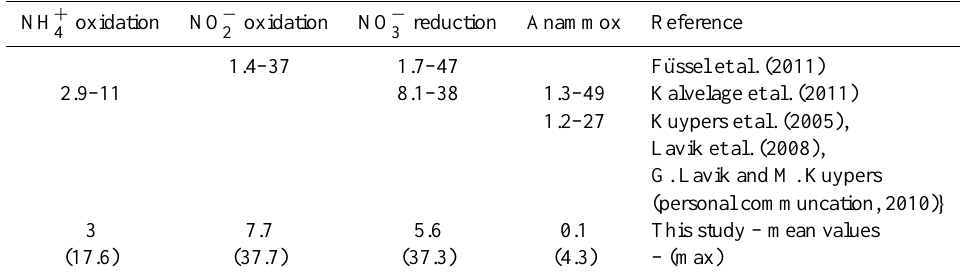
Fig. 12. Vertical profiles of horizontally averaged (a) and maximum (b) N 2 O concentrations between 22–24 ◦ S and 10–15 ◦ E (in 10 − 3 mmolN 2 Om − 3 ) from the surface to 600m depth for different parameterizations (Nevison et al., 2003; Suntharalingam et al., 2000, 2012), β coefficient (Suntharalingam et al., 2000, 2012), and sensitivity analyses on key parameters. Vertical profiles were 8yr averaged. Vertical profiles of averaged N 2 O concentrations between 22–24 ◦ S and 12.5–15 ◦ E, zonal extension of the OMZ at this latitude range, overlap in (a) . Red stars represent in situ measurements from the FRS Africana cruise in December 2009. Table 6. In situ and simulated estimations of NH + and NO − oxidation, NO − reduction, and anammox (10 − 2 mmolNm − 3 d − 1 ) in the 4 2 3 OMZ off Namibia. Simulated estimations are 8yr mean values from the “reference simulation” (Test no. 15), computed between 22–24 ◦ S and 10–15 ◦ E. In parenthesis are the maximum